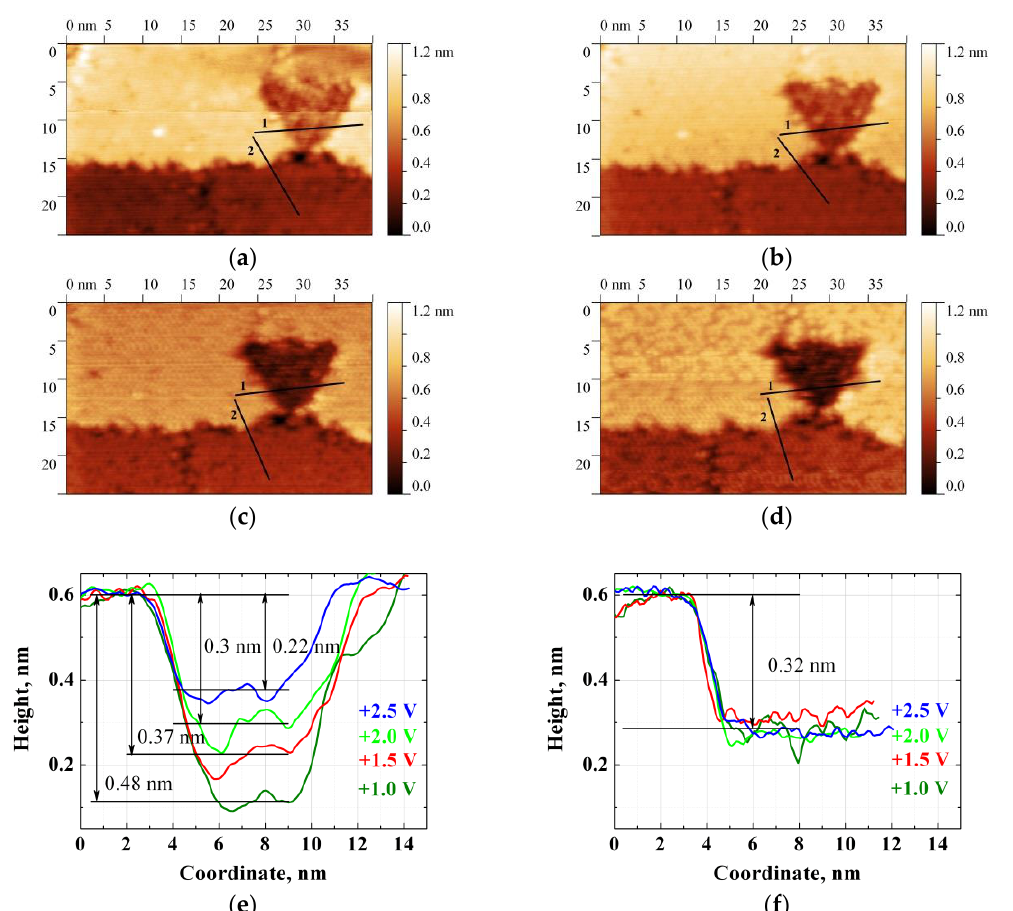
Figure 5. ( a – d ) Comparison of the contrast behavior at the boundary between (7 × 7) N and (8 × 8) island versus voltage: ( a ) +2.5 V, ( b ) +2.0 V, ( c ) +1.5 V, ( d ) +1.0 V. ( e ) “Depth” profiles of the triangular island at the (7 × 7) N and (8 × 8) boundaries along the line #1 at various voltages; ( f ) the morphological step depth along line #2 as a function of bias. The profiles are deliberately aligned at the level of the “ upper terrace “ for an easier comparison.